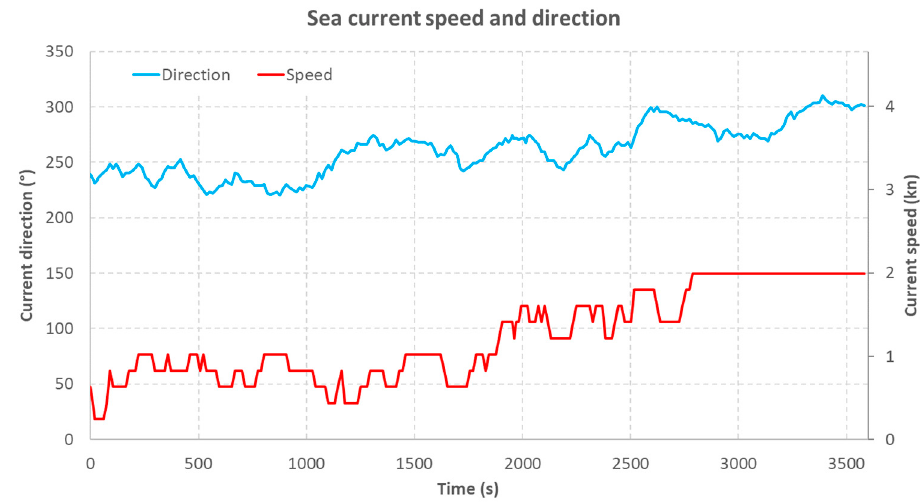
Figure 22. Sea current speed and direction during the simulation.